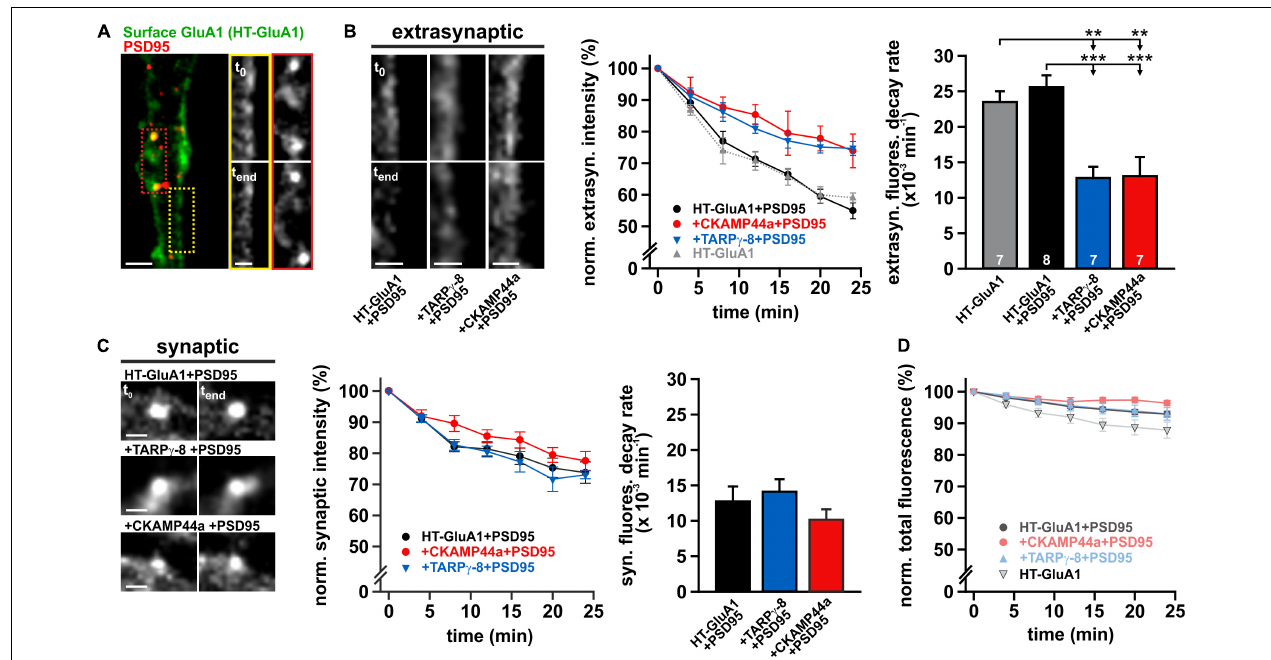
FIGURE 5 | Overexpression of auxiliary subunits reduces basal AMPAR internalization. (A) Confocal image of a representative dendritic segment from a neuron that was co-transfected with HaloTag (HT)-GluA1 and PSD95-tagRFPt to separately follow extrasynaptic and synaptic receptor turnover (scale bar = 4 µ m). Cropped detail pictures show labeled GluA1-receptors at the marked extrasynaptic (yellow box) and synaptic regions (red box) directly after staining (t 0 ) and after 24 min incubation (t end ) (scale bar = 2 µ m). (B) Example images show the internalization of extrasynaptic receptors at dendritic segments of control neurons and cells overexpressing TARP γ -8 or CKAMP44a (scale bars = 2 µ m). The internalization kinetics of labeled surface AMPARs at extrasynaptic sites were quantified for each experimental group (middle panel) . The averaged fluorescence decay profile for controls (+PSD95) is depicted in black, for neurons overexpressing TARP γ -8 in blue, and for cells overexpressing CKAMP44a in red. The gray, dotted line outlines the fluorescence decay in control cells not expressing the synaptic marker PSD95-tagRFPt. Data was fit by monoexponential functions to determine the internalization rate (right panel) . (C) Analogous analysis of fluorescence decay for labeled HT-GluA1-containing AMPARs at synaptic sites (scale bars = 2 µ m). (D) Bleaching was estimated by quantifying the relative loss of summed fluorescence of the full image. All depicted data are mean ± SEM. n -values for the experimental groups shown in panel (B) also apply to all other panels. Statistical analysis was performed with one-way ANOVA and Tukey post hoc test. ** p < 0.01; *** p <